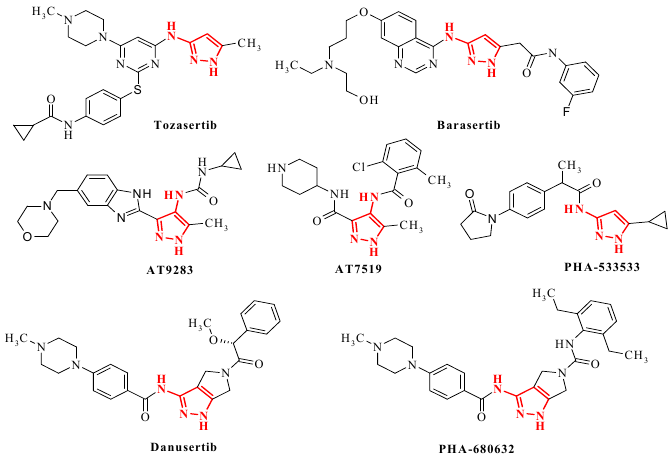
Figure 1. The structures of representative protein kinases inhibitors based on the aminopyrazole